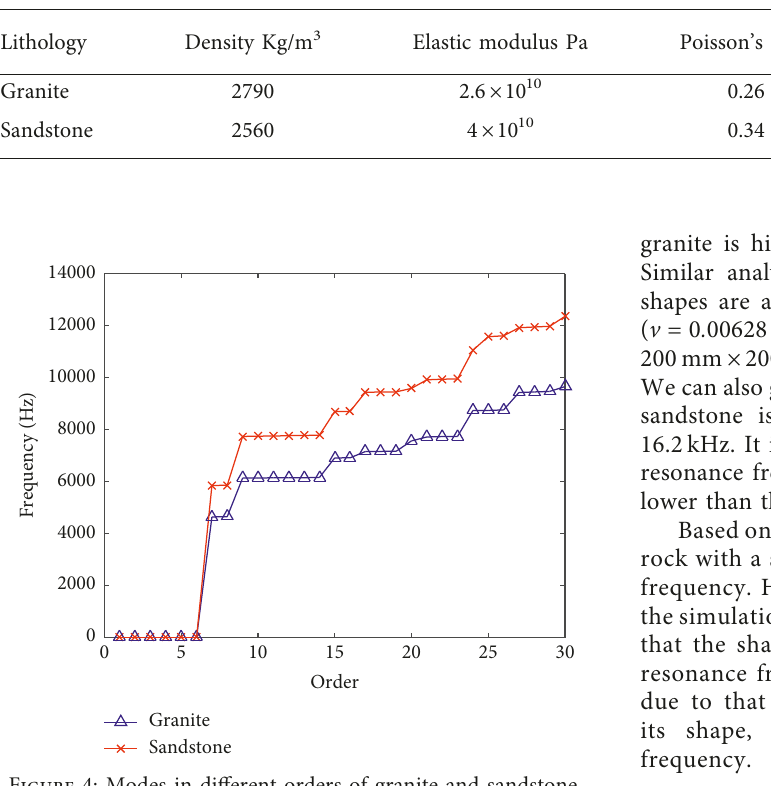
Table 1: Property parameters of rocks in the numerical simulation.